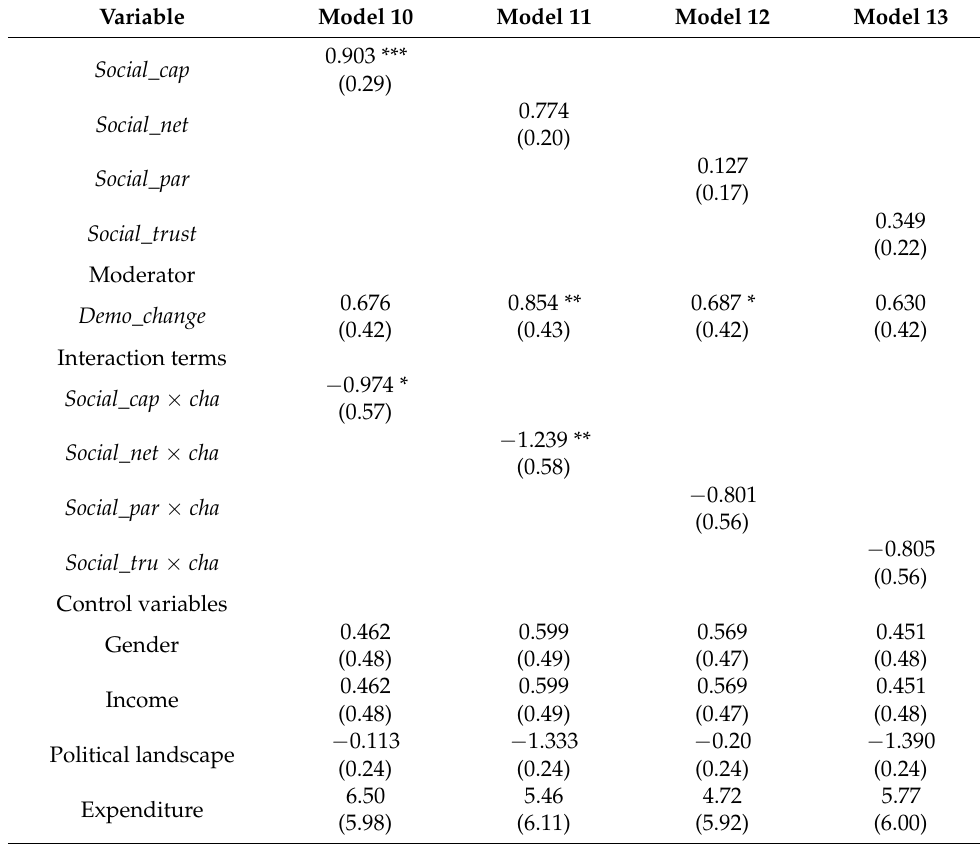
Table 4. The moderating effects of demographic